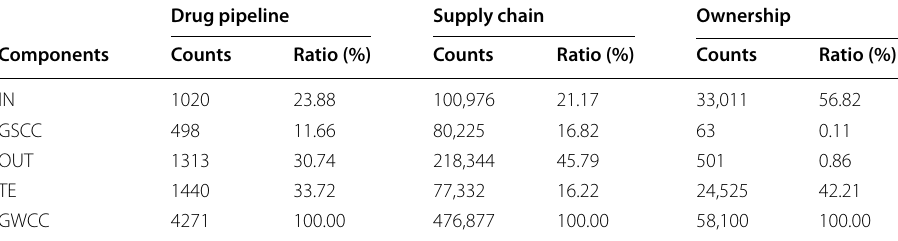
Table 6 The sizes of different components based on the bow tie decomposition for each layer Drug pipeline Supply chain Ownership Components Counts Ratio (%) Counts Ratio (%) Counts Ratio (%)